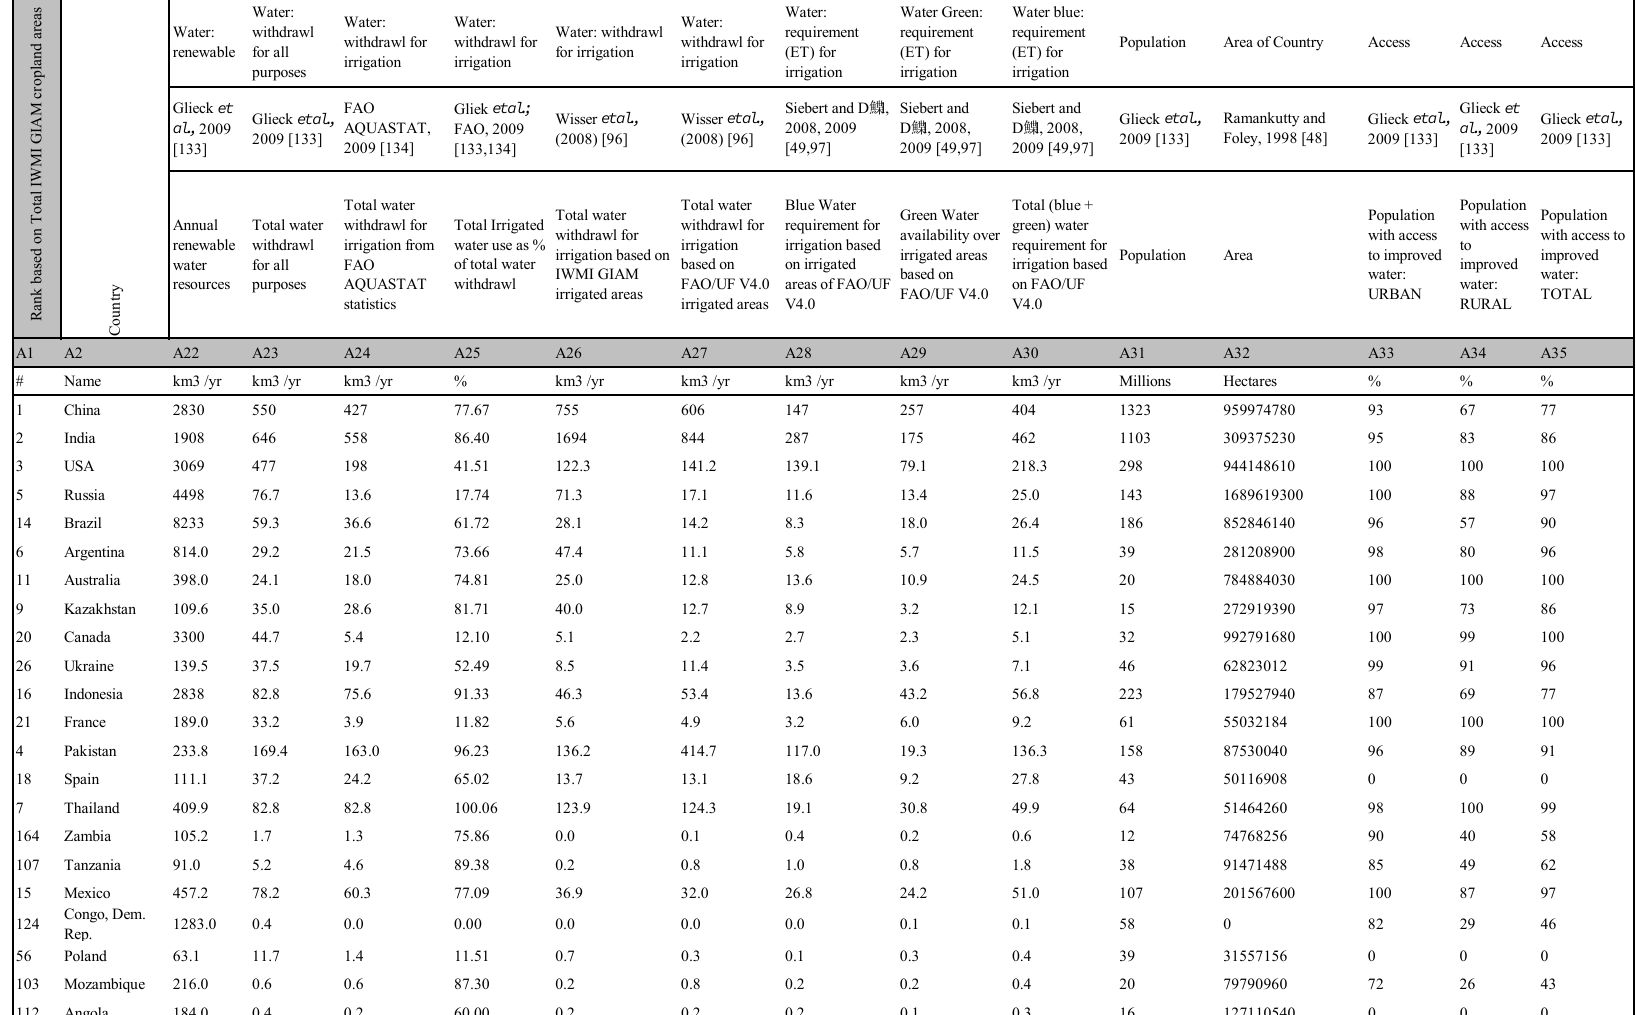
Table 3. Global water withdrawals versus water use by croplands—a country by country assessment. Also, blue water and green water use of irrigated